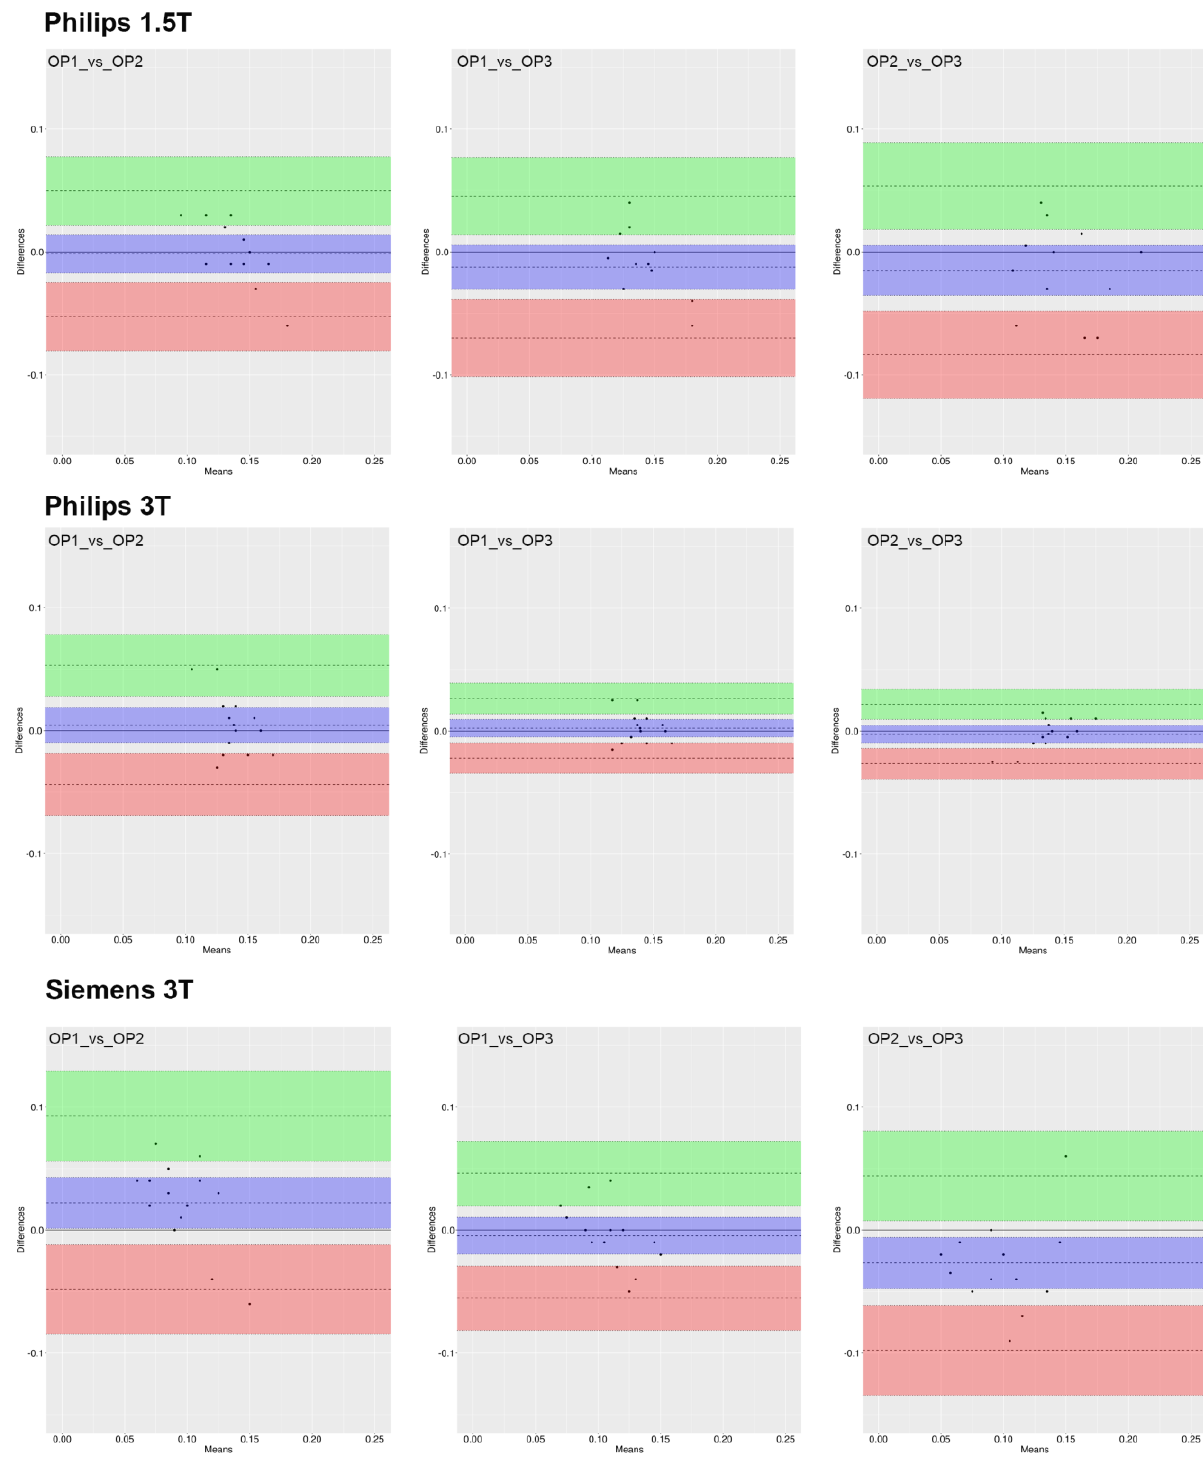
Figure 4. Bland–Altman plot of AxialWSS measures for each pair of raters. The dashed line represents the mean difference along with the 95% CI (violet box). The lower (red box) and higher (green box) limits of agreement (LoA) defined as the mean difference ± 1.96 standard deviations of differences are reported along with the corresponding 95% CI.